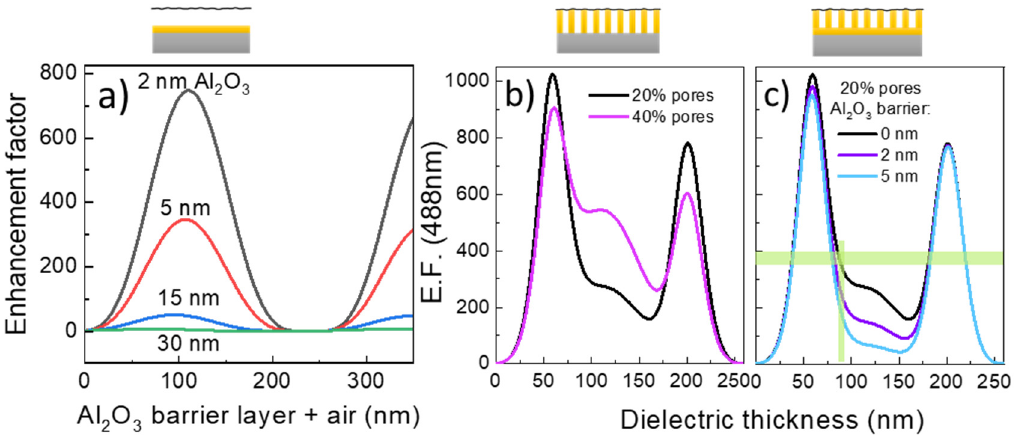
Figure 6. E.F. calculated at 488 nm laser excitation for ( a ) a dielectric formed by air and an Al 2 O 3 barrier of the indicated thickness, ( b ) different pore fractions without barrier and ( c ) pore fraction of 20% and alumina barrier layer of 0, 2 and 5 nm. The horizontal green line corresponds to the experimental E.F. value.